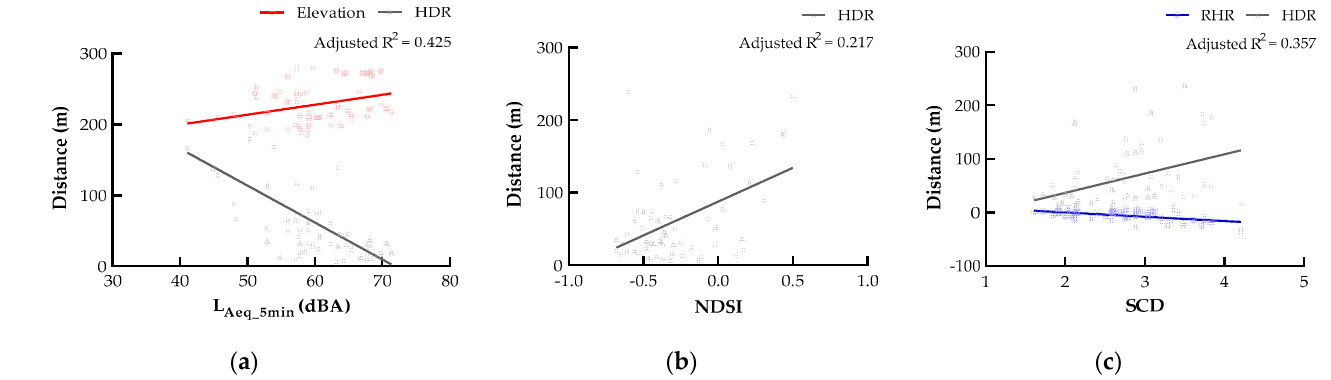
Figure 5. Linear regression curves between spatial indicators and soundscape evaluation parameters: ( a ) spatial indicators and L Aeq_5min ; ( b ) spatial indicators and NDSI; ( c ) spatial indicators and SCD.